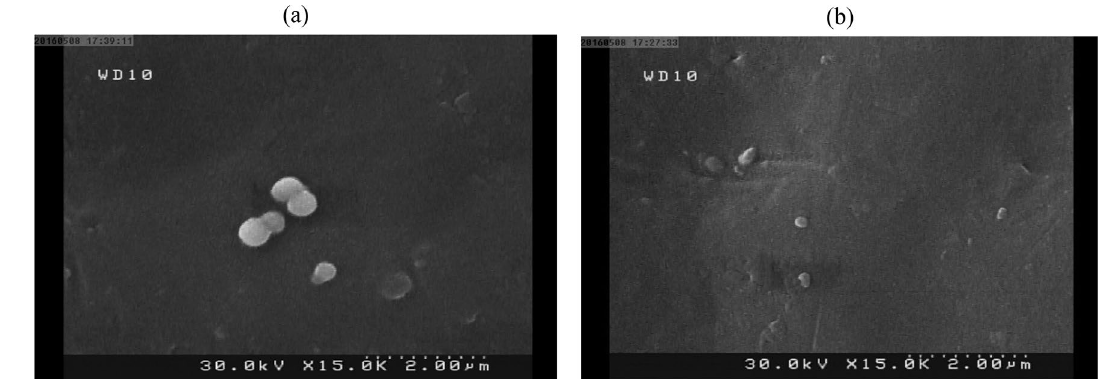
Fig. 7 SEM micrographs of Au and AgNPs samples dried on aluminum foil